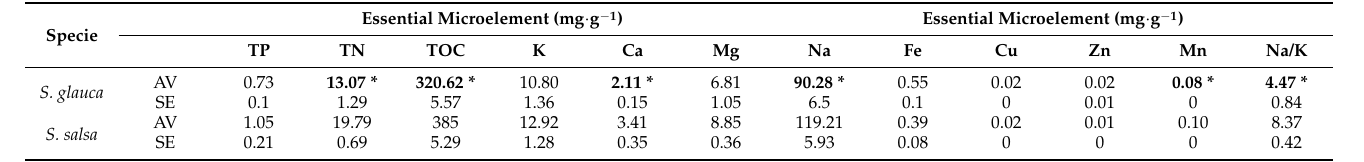
Table 2. Distribution of the contents of 11 elements in S. glauca and S. salsa .